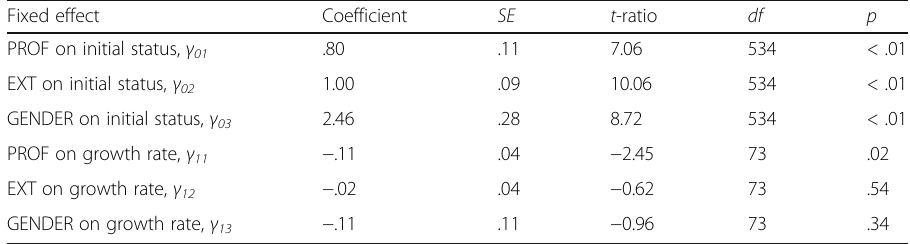
Table 5 Estimation of significant effects of individual differences on initial status growth of